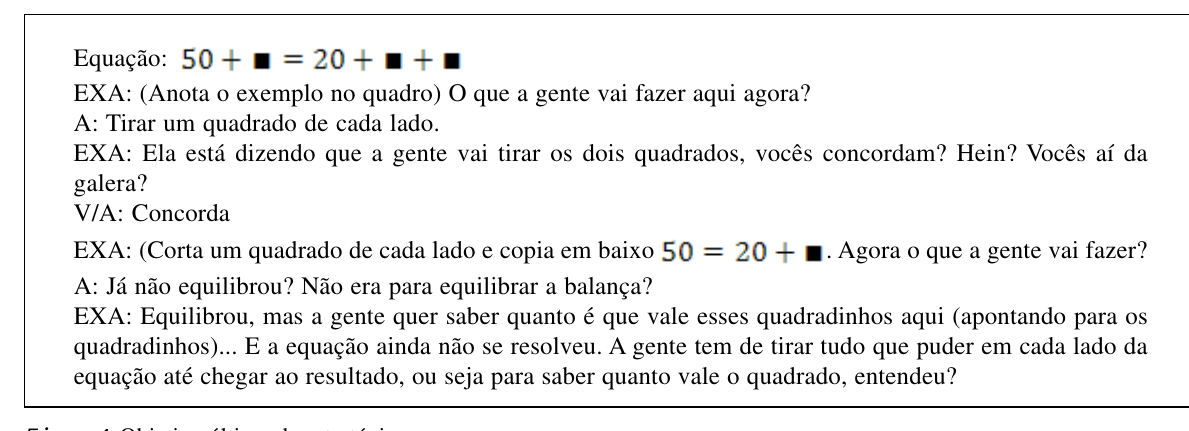
Figura 3 . Retirada dos fatores em um membro e não em outro, altera a equivalência da equação episódio a examinadora volta a explicitar a